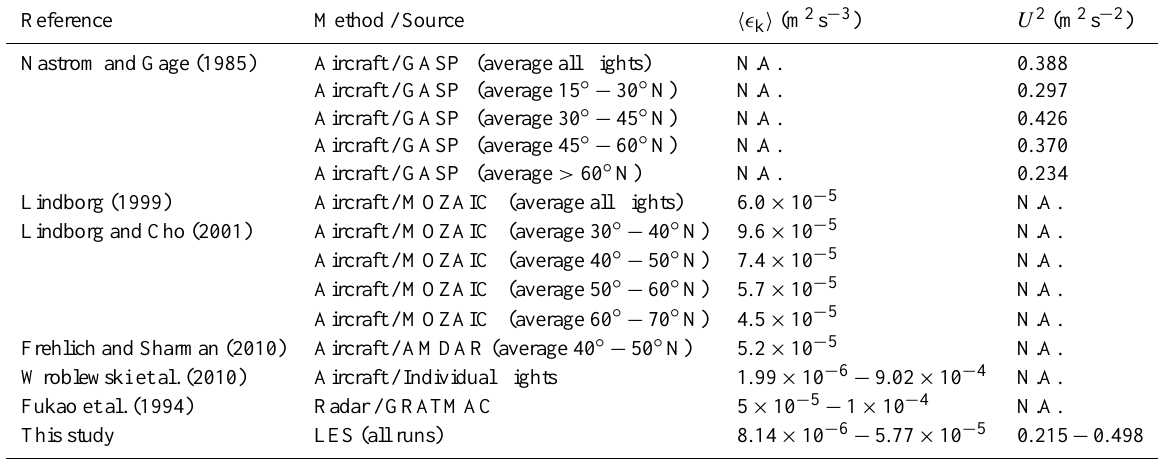
Table 3. Comparison with data from observational analysis. Variances from Nastrom and Gage (1985) data are obtained by integrating the portion of energy spectrum in the range of wavelengths 12 . 5km < λ h < 25km, and are reconstructed by summing up the variances in the north–south and east–west